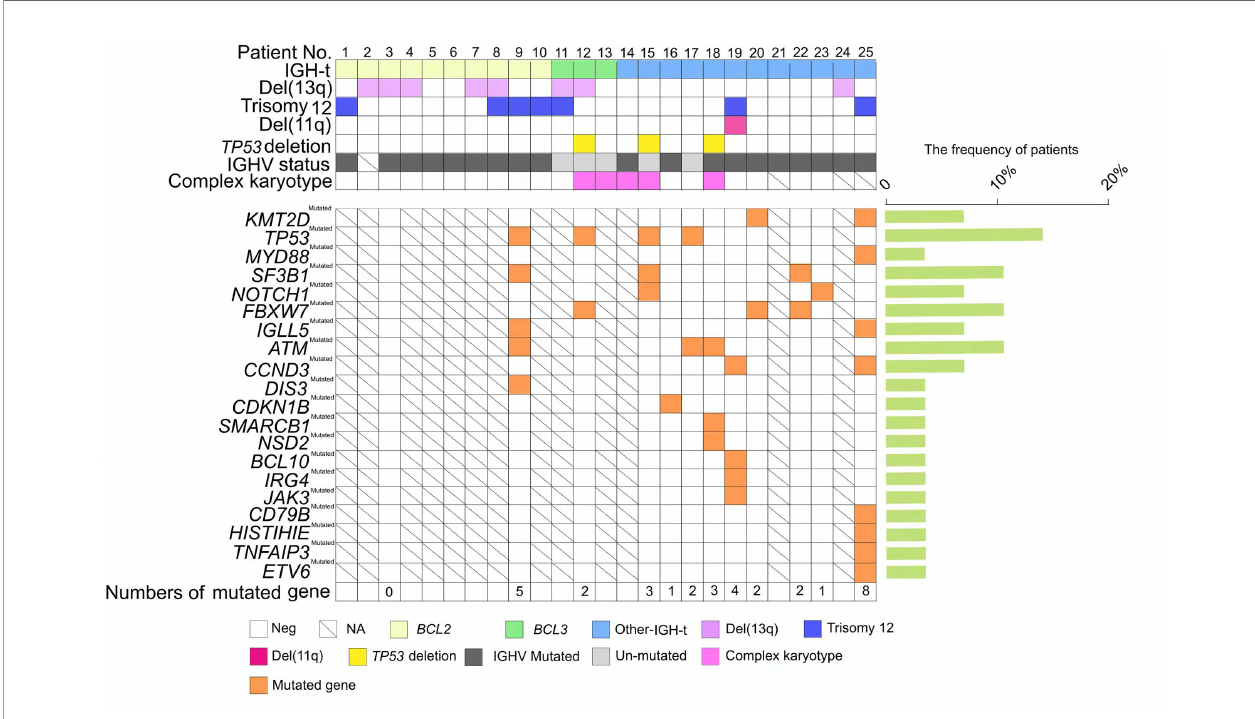
FIGURE 1 | Genetic pro fi les of chronic lymphocytic leukemia (CLL) patients with immunoglobulin heavy chain (IGH) translocation. Each column represents one patient (n = 25); CLL patients with IGH translocation are clustered into three groups: IGH-BCL2, depicted in light yellow; IGH-BCL3, depicted in light green; and other IGH-t, depicted in light blue. Each row pertains to one genetic factor, which is listed on the left side including del(13q), trisomy 12, del(11q), TP53 deletion, IGHV status, and complex karyotype. IGHV unmutated status is represented by light grey and IGHV mutated status is represented by dark grey. The presence of a certain mutated gene is shown in orange, and the frequent percentages (%) are listed on the right histogram. Parameters are not available for codes with a slash. Blank code: parameter negative. Colored code: parameter positive.